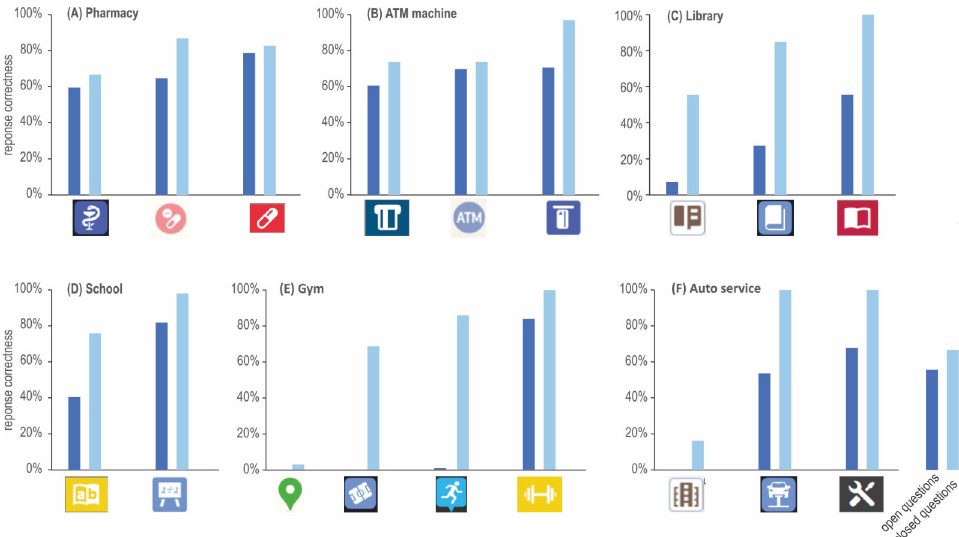
Fig. 4. Correct recognition of symbol